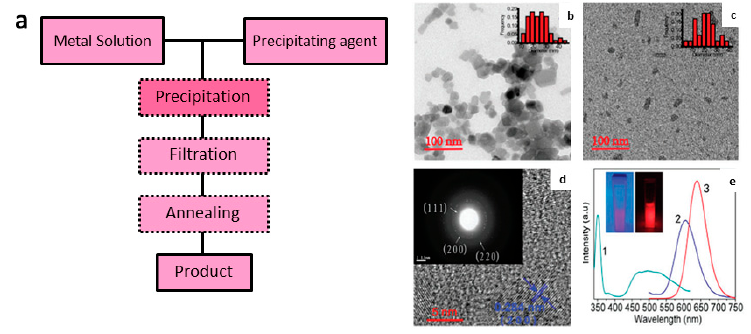
Figure 12. ( a ) Schematic flowchart of CPC. TEM images and (inset) histograms of the particle size distribution of ( b ) CaS:Eu 2+ , Sm 3+ , Mn 2+ and ( c ) functionalized CaS:Eu 2+ , Sm 3+ , Mn 2+ . ( d ) HRTEM of CaS:Eu 2+ , Sm 3+ , Mn 2+ . The inset shows the SAED pattern. ( e ) Excitation (1 – green line, left), PeL emission (2 – purple line, right), and up ‐ conversion emission (3 – red line, right) spectra. The inset shows photographs of CaS:Eu 2+ , Sm 3+ , Mn 2+ under UV (left) and NIR excitation (right). λ em = 610 nm, λ exc = 355 nm (PeL) or λ exc = 980 nm (UC). Reproduced from [227] with permission from The Royal Society of Chemistry.